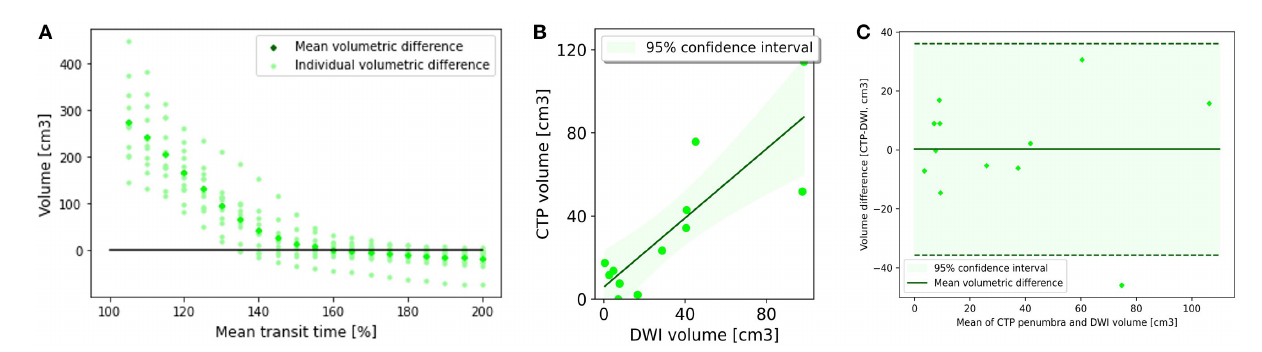
FIGURE2 Penumbral analysis. (A) Mean volumetric difference between follow up diffusion weighted imaging lesion and acute perfusion lesion according to mean transit time threshold. In Group 1, the perfusion lesion identified at a MTT of > 160% resulted in the smallest volumetric difference with follow up MRI (0.31 ml3, CI − 11.98 to 12.53). (B) CTP lesion volume using Mean transit time > 160% vs. 24h DWI lesion volume. There was good correlation between the acute perfusion lesion and follow up imaging volume ( R 2 = 0.71). (C) Bland-Altman plot demonstrating the volumetric agreement between the perfusion lesion at Mean Transit time > 160% and follow up DWI. There is reasonable agreement with the majority of cases (11 of 12) within the 95% confidence interval.